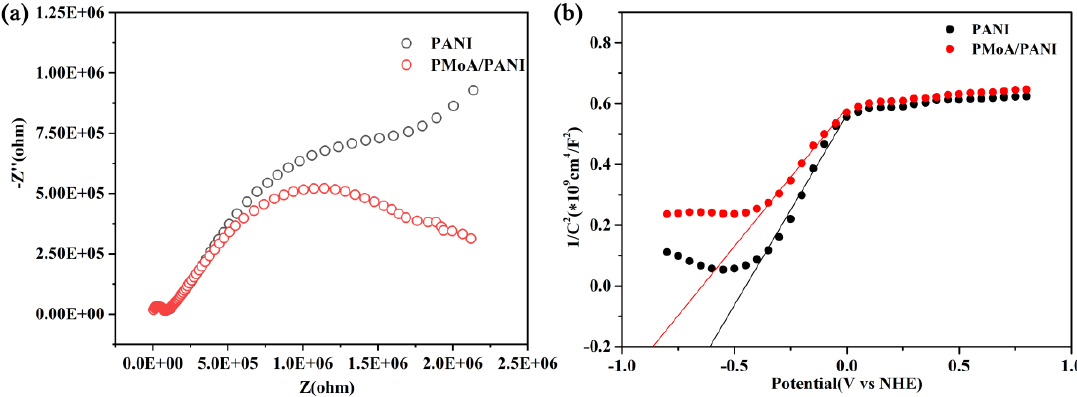
Figure 7. Electrochemistry study of EIS of PANI and the PMoA / PANI hybrid thin film ( a ) EIS of PANI and the PMoA / PANI hybrid thin film. ( b ) Mott-Schottky curve of PANI and the PMoA / PANI hybrid thin film.